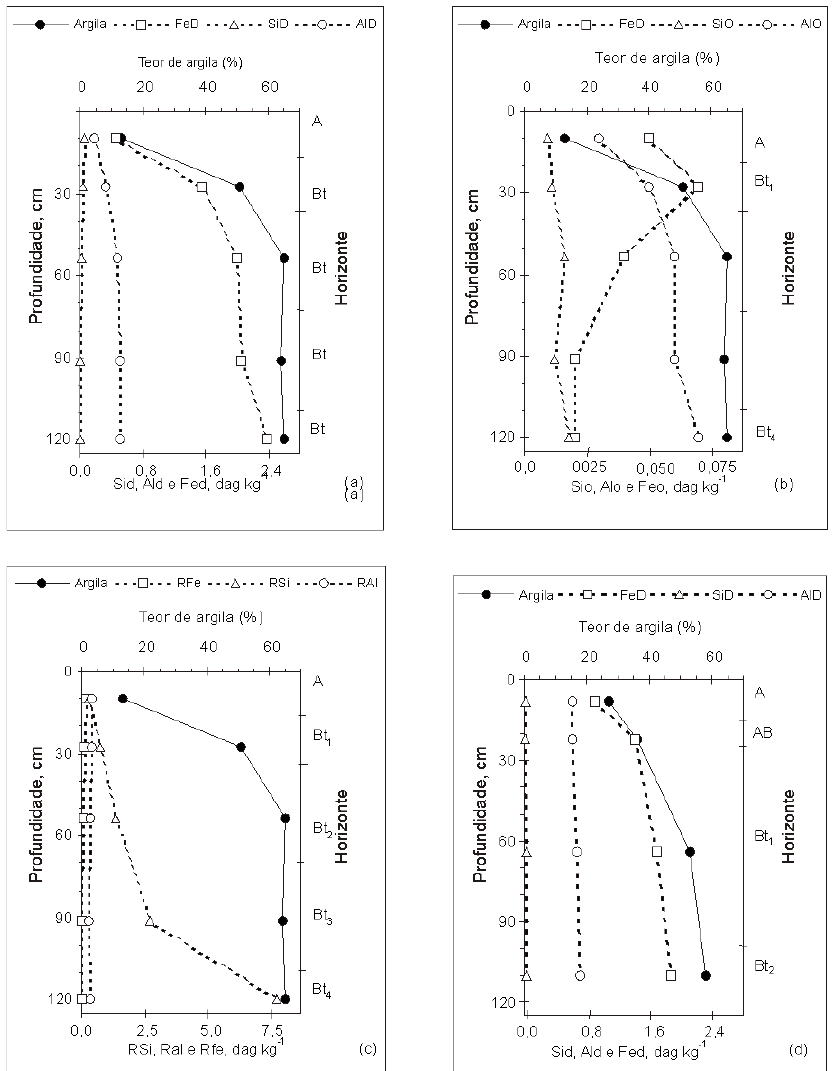
Figura 1. Curva do teor de argila e formas extraídas de Si, Al e Fe com ditionito, oxalato e relações RSi (Sio/ Sid), RAl (Alo/Ald), RFe (Feo/Fed) em profundidade nos Argissolos Amarelos abrúpticos (a, b e c) e no típico